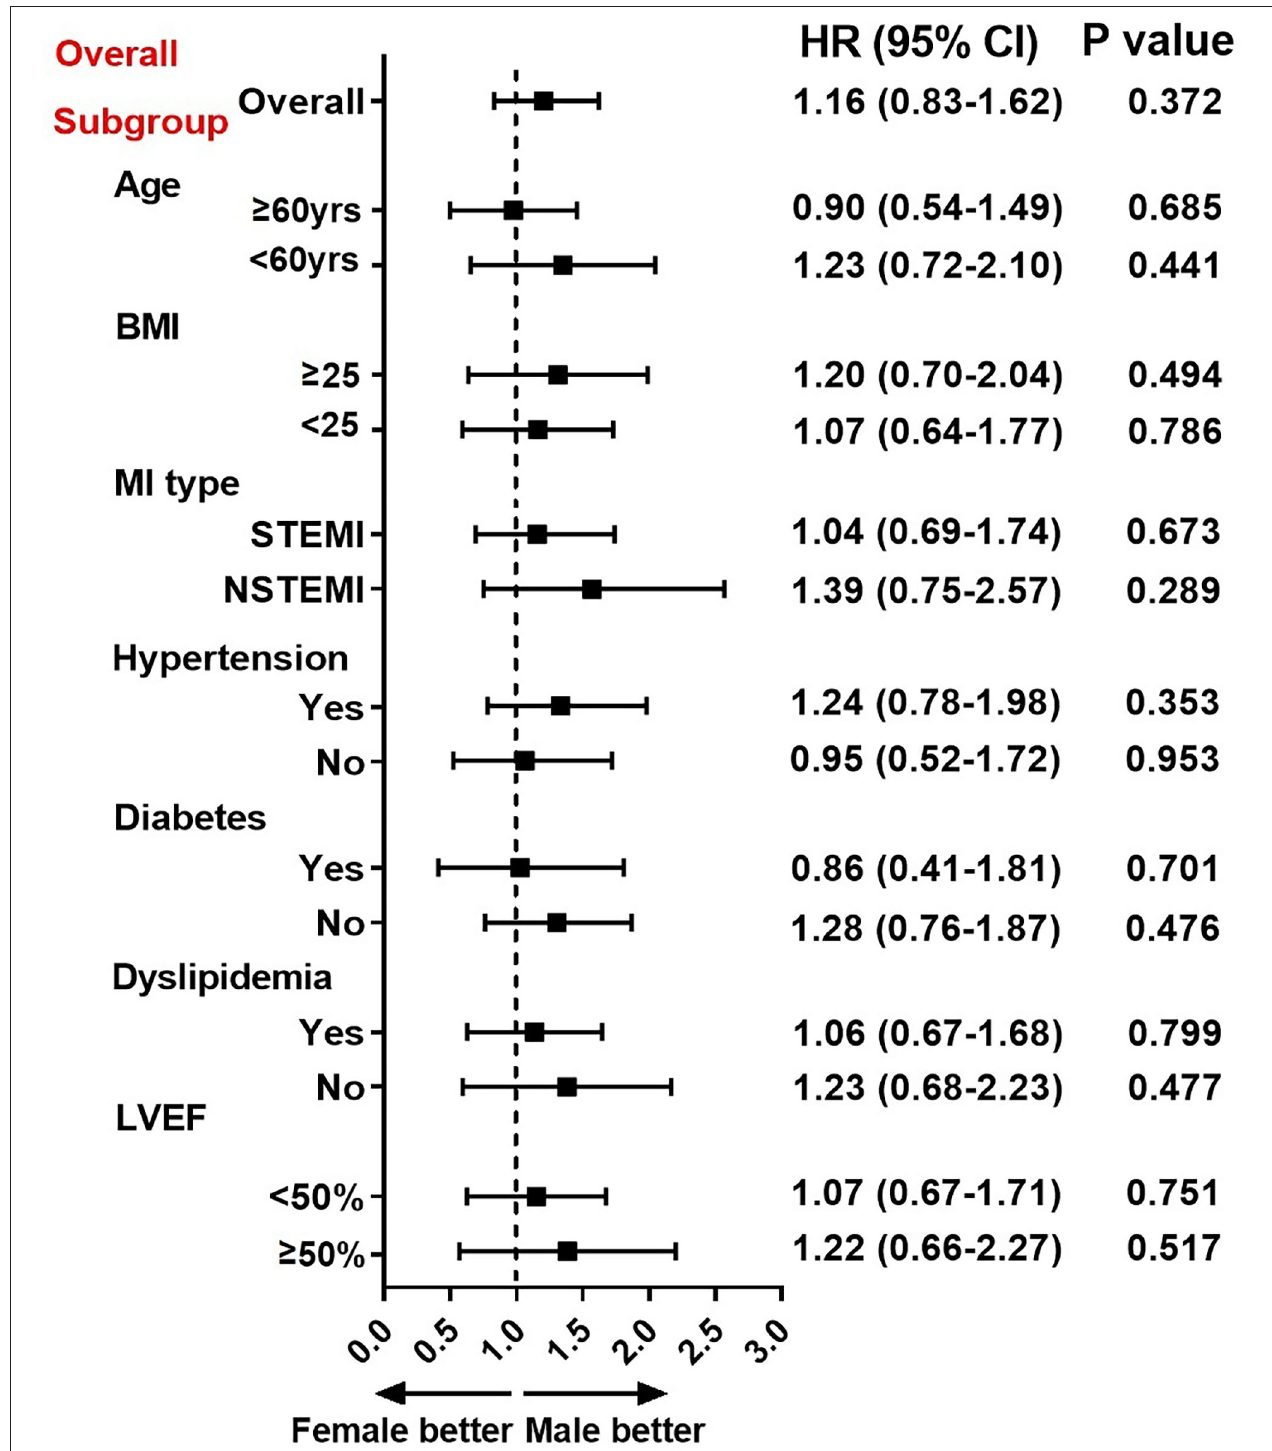
FIGURE 3 | Association between gender and risk of MACE in overall and subgroups. Subgroup analysis showing the association between sex and risk of MACE in subsets of MINOCA patients. Hazard ratio (HR) was expressed as female-to-male risk ratio and calculated by univariate Cox regression analysis. The vertical dotted line indicated the HR value of 1. CI, confidence interval; BMI, body mass index; LVEF, left ventricular ejection fraction; STEMI, ST-segment elevation myocardial infarction; NSTEMI, non-ST-segment elevation myocardial infarction.